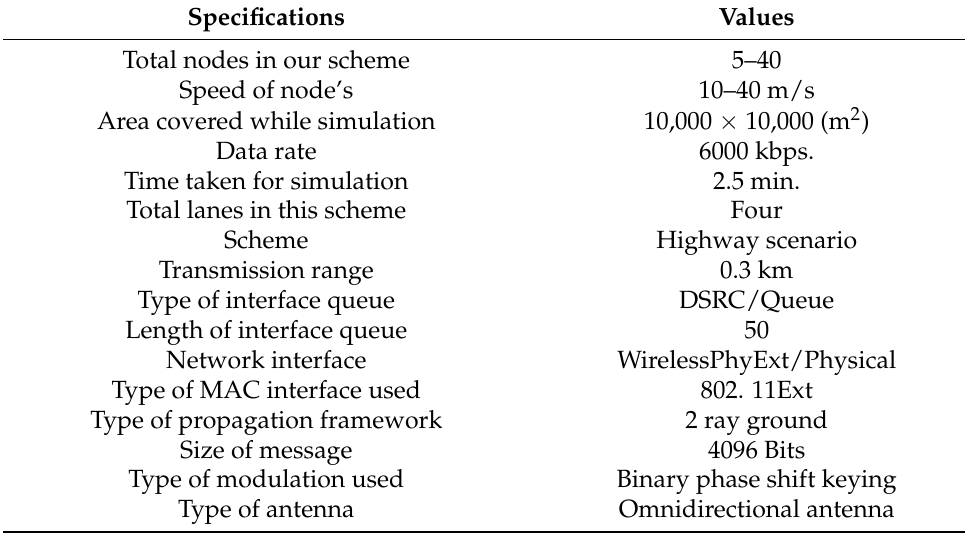
Table 1. Parameters used in the